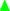
Geocoded locations of herbarium specimens from 10 Rhododendron taxa predicted in this study and supported by literature as being lime tolerant: R. davidsonianum
(A), R. fortunei
(B), R. micranthum
(C), R. nivale
(D), R. phaeochrysum
(E), R. primuliflorum
(F), R. telmateium
(G), R. trichocladum
(H), R. vernicosum
(I), R. yunnanense
(J). : Specimen at a location with pH < 7.2 and CaCO3 content < 2% weight in topsoils. : Specimen at a location with pH > 7.2 and CaCO3 content > 2% weight in topsoil.